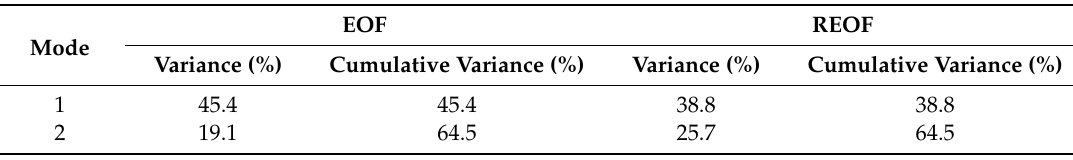
Table 1. The percentage of variance and cumulative variance of two leading modes of empirical orthogonal function (EOF) and rotate empirical orthogonal function (REOF).